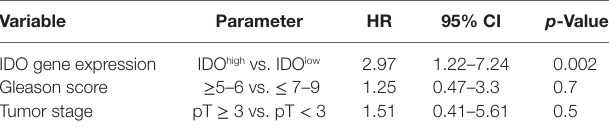
TaBle 4 | Multivariate Cox regression analysis of the risk of biochemical recurrence (BR) associated with indoleamine 2,3-dioxygenase (IDO) gene expression level stratification adjusted for tumor stage (>3 vs ≥3) and Gleason score (≥6 vs ≥7).